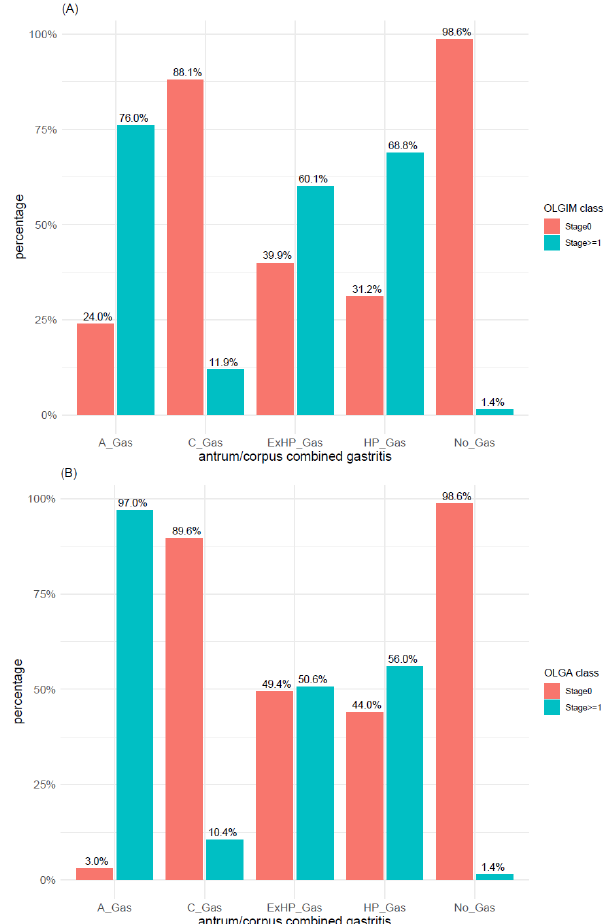
Figure 7. Distribution of ( A ) intestinal metaplasia and ( B ) atrophy within the main gastritis types according to OLGA and OLGIM classes (stage 0 vs. stages 1–4). TubA: intestinal-type adenoma; PGA: pyloric gland adenoma; FovA: foveolar-type adenoma; OGA: oxyntic gland adenoma; A_Gas: autoimmune gastritis; C_Gas: chemical reactive gastritis; ExHP_Gas: Ex- H. pylori Gastritis; HP_Gas: H. pylori Gastritis; No_Gas: no gastritis; OLGA: operative link on gastritis assessment; OLGIM: operative link on gastric intestinal metaplasia assessment.